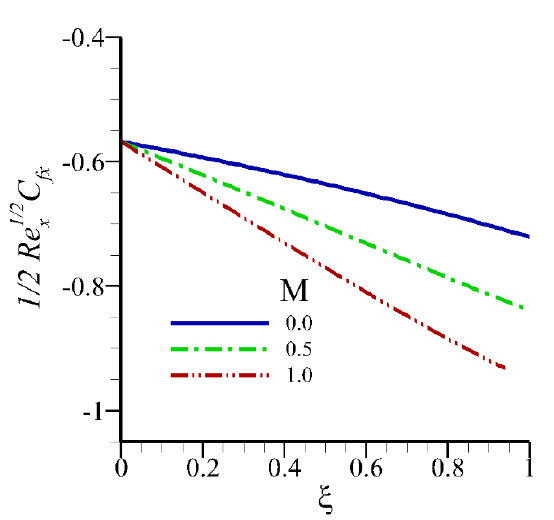
Re 1/2 x C f Figure 6. Graph of 1 with ξ for changed values of M while Pr = λ = 1.0, and R d = 0.5. 2 x 1 Figure 7a,b unveil the impact of di ff erent Pr values on f Figure 6. Graph of 1 Figure 6. Graph of